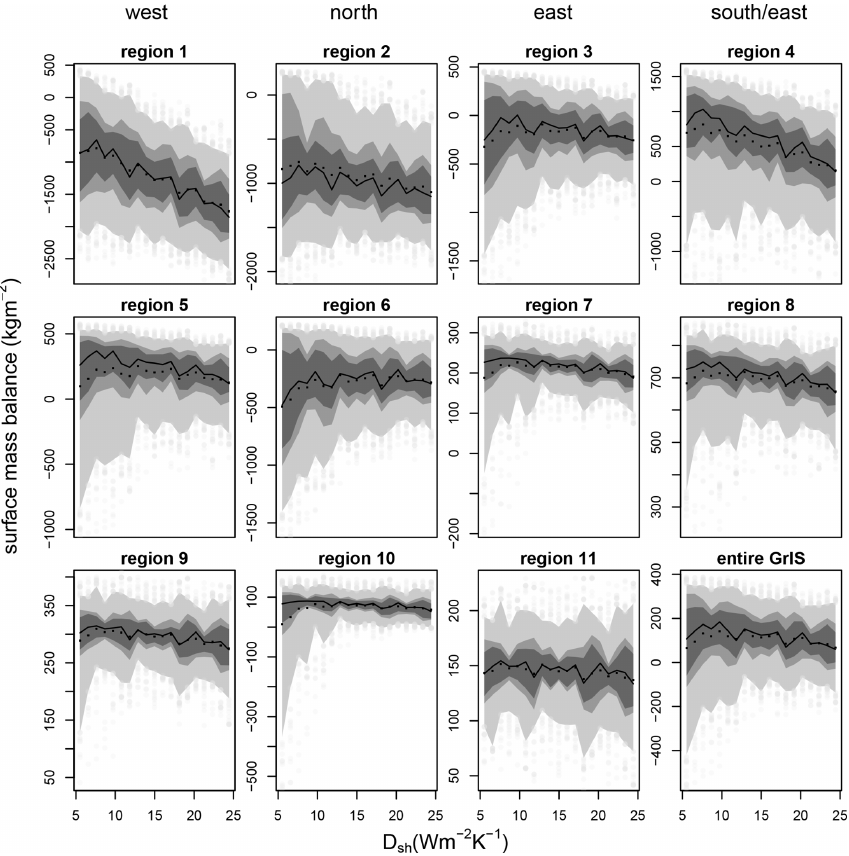
Figure 8. The dependency of the SMB on the turbulent heat exchange coefficient D SH is displayed in a similar manner to in Fig. 7 for the PD. The shading represents the different quantiles: 5th and 95th (light grey), 25th and 75th (grey), 33rd and 66th (dark), and the median (solid black line). The black dots are the ensemble mean based on 20 intervals. The panels are sorted by elevation and regions, with the lowest elevation (0–1000m) in the top row and the highest elevation at the bottom. Each column is related to a region in Greenland: W, N, E, SE–S (Fig.